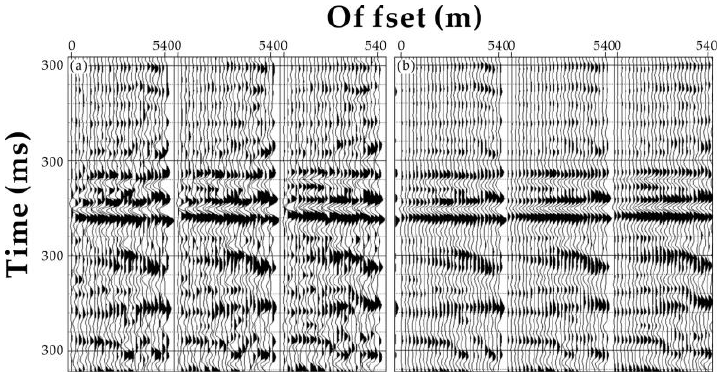
Figure 9. Comparison of 3D seismic tracking data before and after optimization process. ( a ) is the seismic profile before optimization. ( b ) is the optimized seismic profile.